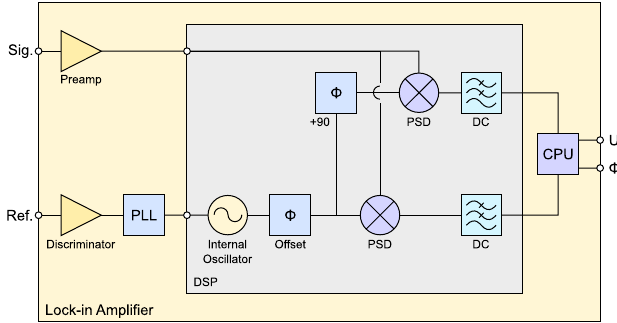
FIG. 5. Simplified block schematic of the SR830 lock-in am- plifier